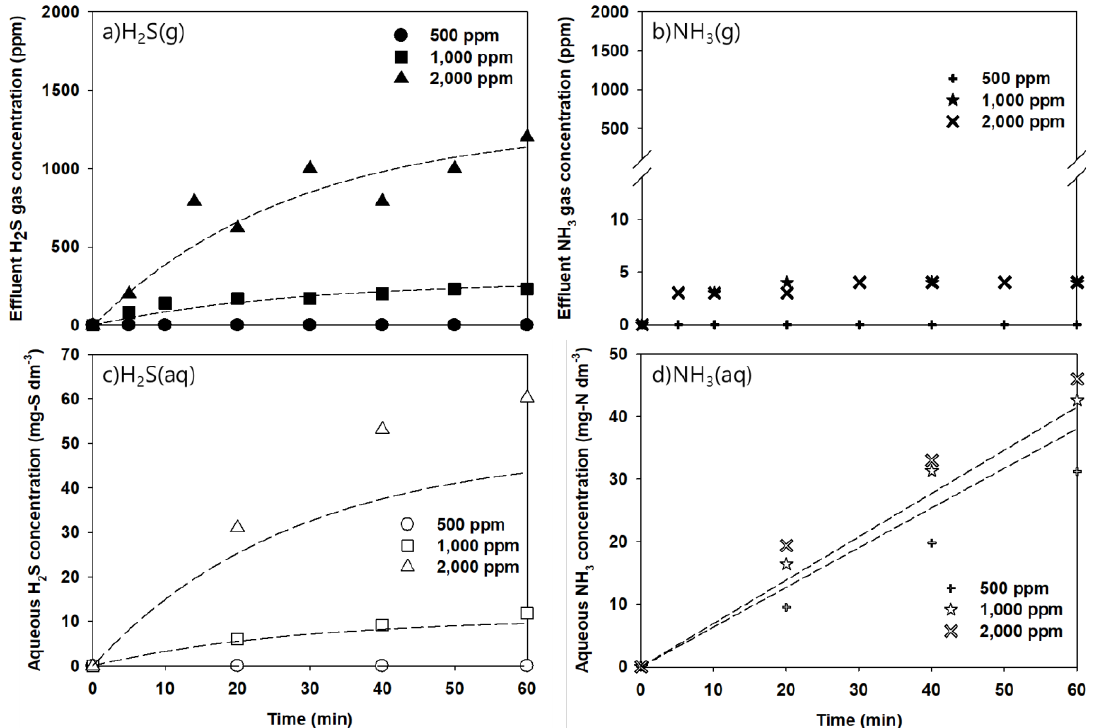
Figure 2. Changes in the concentrations of ( a ) gaseous H 2 S, ( b ) gaseous NH 3 , ( c ) aqueous H 2 S, and ( d ) aqueous NH 3 under different H 2 S inlet concentrations (dotted lines indicate model prediction results).